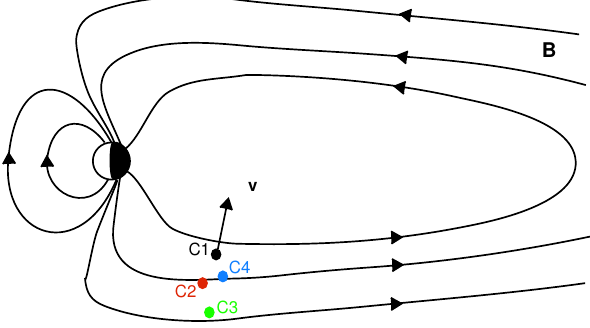
Fig. 1. Sketch of the position and configuration of the Cluster satel- lites at the around 05:26 UT on 19 May